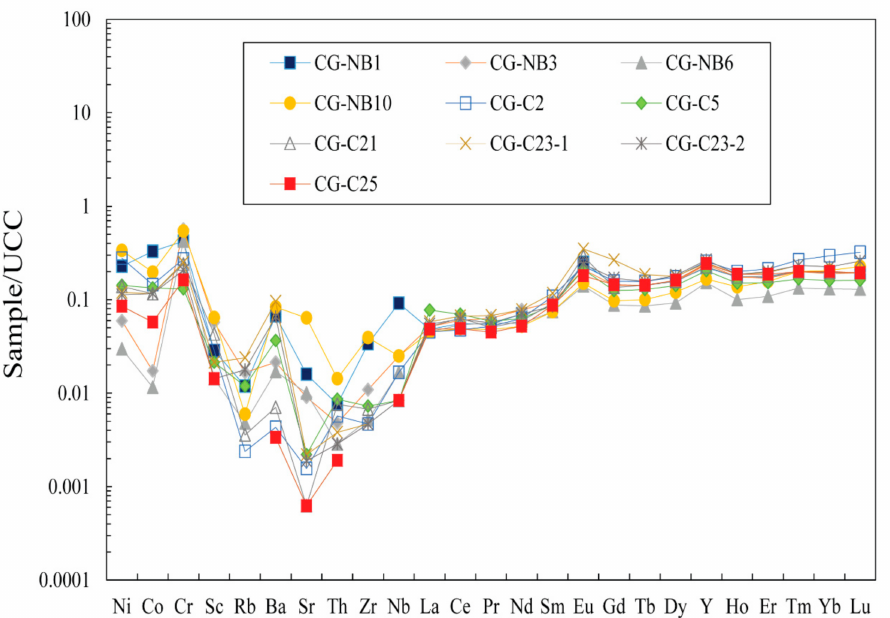
Figure 7. Upper continental crust (UCC)-normalized trace element patterns of the Nabeba BIF. UCC normalizing values from